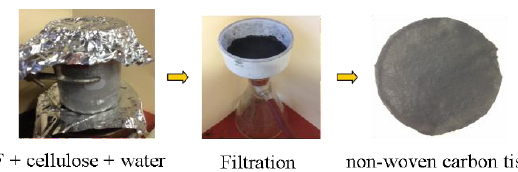
Figure 1. The procedure of preparing non-woven carbon tissue.